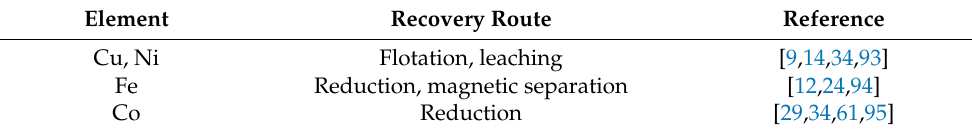
Table 3. Possible recovery routes used in previous research on copper